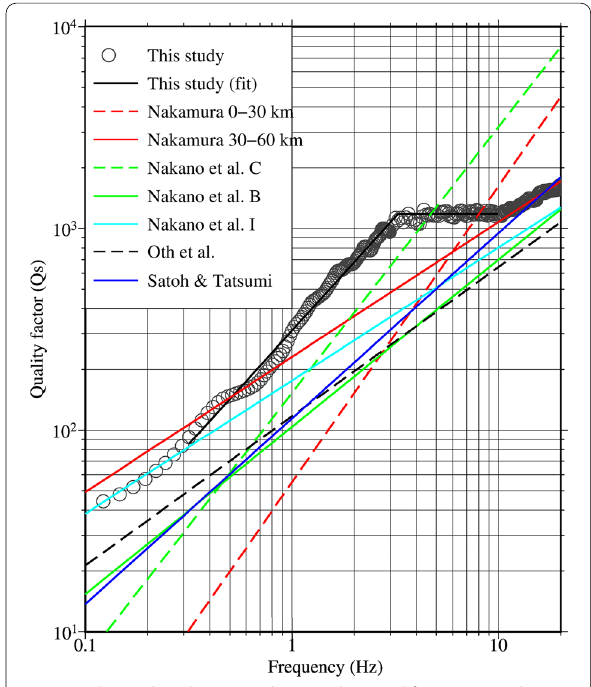
Fig. 7 Relationships between the Qs values and frequencies. The values obtained in the present study are denoted by circles. The red dashed and solid lines denote the relationships for the shallower (0–30 km) and deeper (30–60 km) parts of the fore-arc region in the north–east Japan (Nakamura 2009). The green dashed line, green solid line, and cyan-colored line denote the relationships for fore-arc region corresponding to the Japan Trench subduction zone for crustal (C), plate boundary (B), and intraslab (I) earthquakes, Region 2, in Nakano et al. (2015). The black dashed line denotes the relationship reported in Oth et al. (2011) for subcrustal earthquakes, and the blue line denotes the relationship reported in Satoh and Tatsumi (2002) for north–east